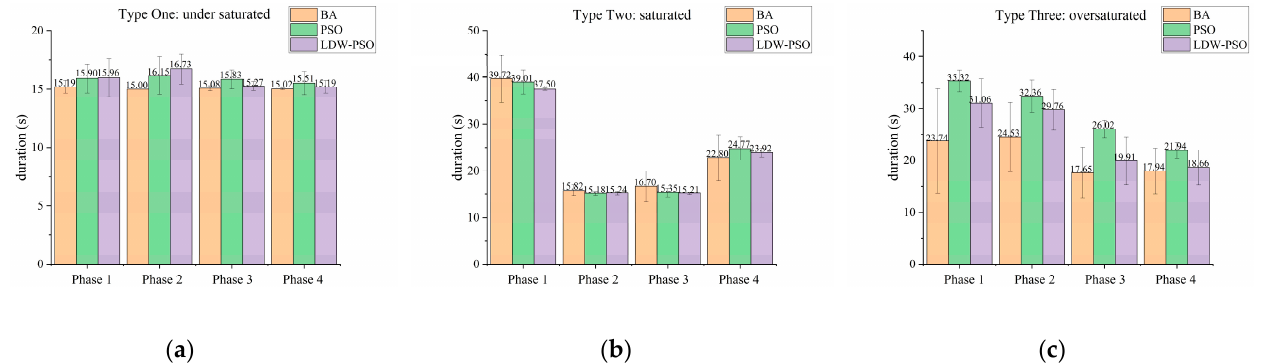
Figure 7. Histogram representation of distribution results of the average phase durations and their error bars. ( a ) Type One; ( b ) Type Two; ( c ) Type Three.